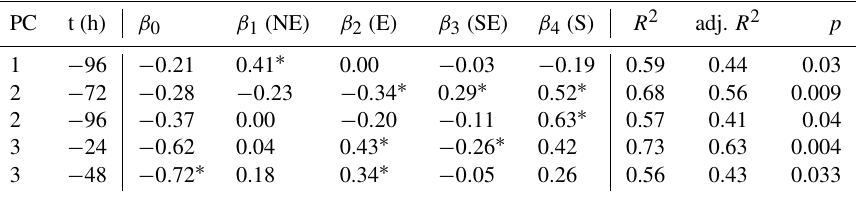
Figure 14. SCD anomaly (in days) for geographic units of mountain ranges within the Clutha Catchment. Mountain ranges are sorted and symbolised by their proximity to the Main Divide of the Southern Alps, revealing spatial gradients in SCD anomaly across the catchment. Table 5. Parameters for significant ( p ≤ 0 . 05) linear multiple regression models between PC loadings and north-east (NE), east (E), south- east (SE) and south (S) trajectory frequency anomalies over varying time periods. Significant ( p ≤ 0 . 05) predictive variables are denoted by ∗